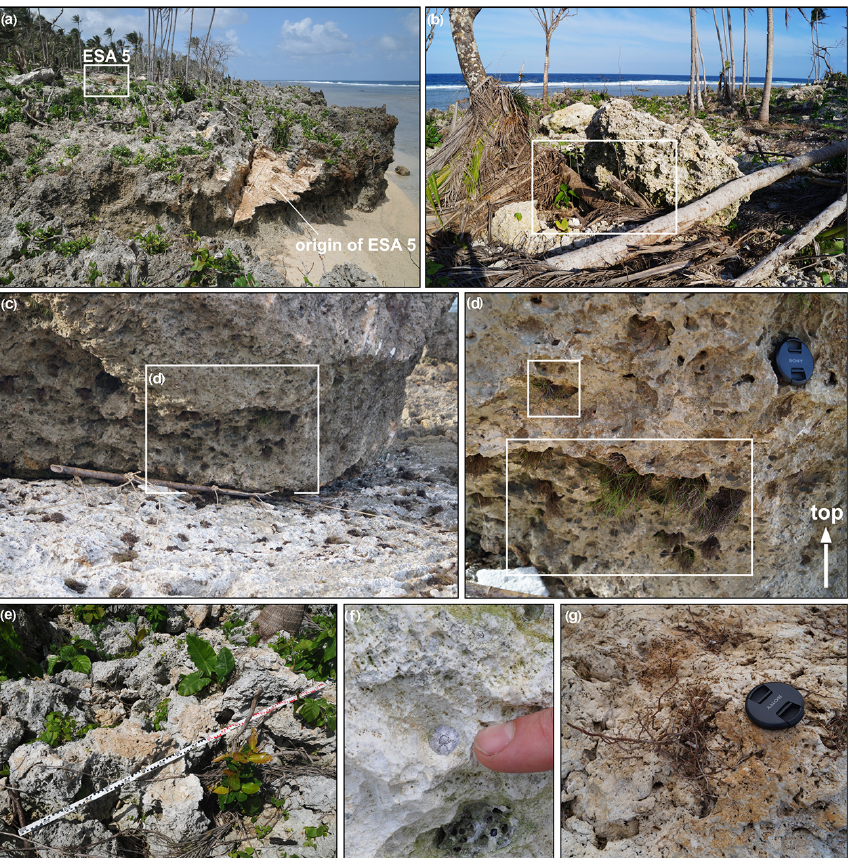
Figure 6. Indicators of boulder movement during Supertyphoon Haiyan. (a) Origin of boulder ESA 5, quarried from the cliff at ∼ 2m MLLW and transported upwards and landwards for 4 and 40m, respectively. Snapped trees and impact marks on the carbonate platform can be traced on its trajectory. (b) Boulder at 6m MLLW lying on top of freshly toppled palm trees. (c) Piece of wood jammed under boulder ESA 7. (d) Downward-facing and decaying grass patches at the former surface and new bottom side of ESA 7. (e) Percussion marks on the Pleistocene carbonate platform, tracing the transport track of ESA 5. Scale is 2m. (f) Still-living barnacle attached to boulder ESA 8, situated at 2.5m MLLW, i.e. clearly above highest tide levels. (g) Roots and soil staining on the exposed former bottom side of several boulders